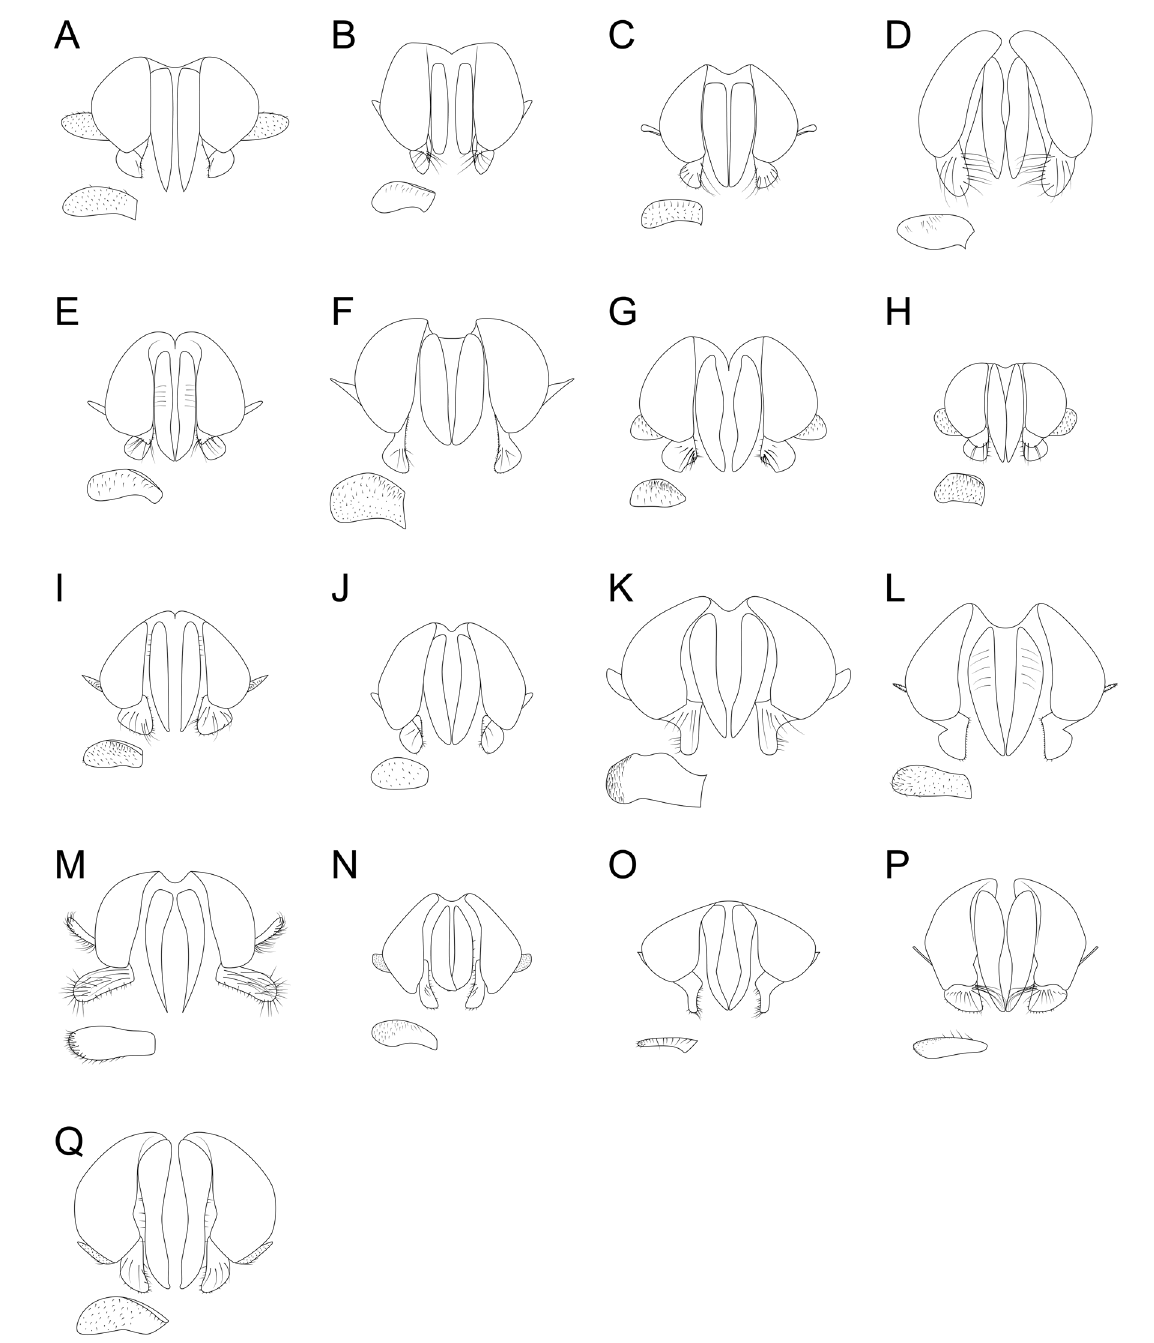
Fig. 90. Male genitalia. A . Lasioglossum ( D. ) arenisaltans sp. nov. B . L. ( D. ) clastipedion sp. nov. C . L. ( D. ) clematisellum (Cockerell, 1904). D . L. ( D. ) hudsoniellum (Cockerell, 1919). E . L. ( D. ) julipile sp. nov. F . L. ( D. ) lilianae sp. nov. G . L. ( D. ) mesillense (Cockerell, 1898). H . L. ( D. ) meteorum sp. nov. I . L. ( D. ) miltolepoides sp. nov. J . L. ( D. ) minckleyi sp. nov. K . L. ( D. ) pallidellum (Ellis, 1914). L . L. ( D. ) pictum (Crawford, 1902). M . L. ( D. ) rufornatum sp. nov. N . L. ( D. ) spivakae sp. nov. O . L. ( D. ) testaceum (Robertson, 1897). P . L. ( D. ) vierecki (Crawford, 1904). Q . L. ( D. ) zephyrus (Smith, 1853). Genitalia are illustrated in dorsal view and positioned such that the gonostylus is parallel to the plane of vision. Retrorse lobes are also illustrated separately to the bottom left of each figure in lateral view, positioned parallel to the plane of